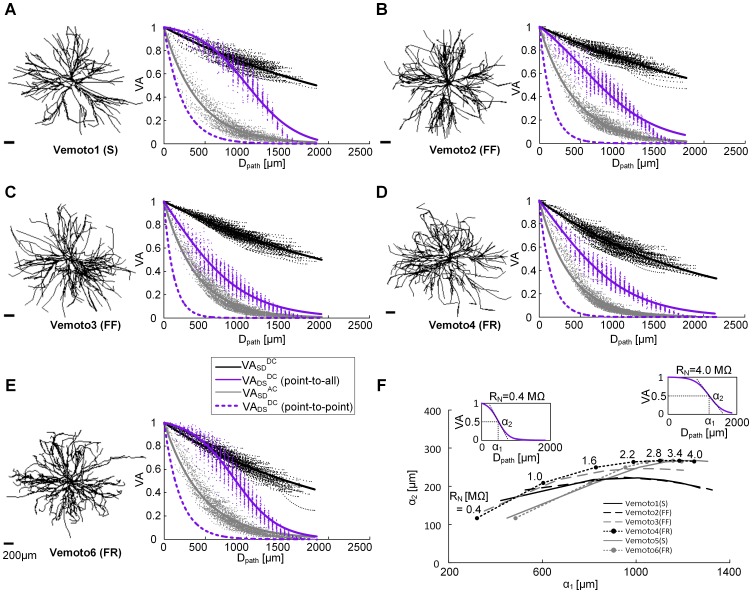
Characterization of voltage attenuation property of the dendrites.(A) – (E). Morphologies of the motoneurons in the left column and the three voltage attenuation (VA) factors measured at all distances (Dpath) from the soma (VASD
DC in black, VASD
AC in gray and VADS
DC in purple) in the right column. A single exponential function (exp(-Dpath/λ)) was used to fit the VASD
DC (λ = 2678.7, 3085.6, 2763.7, 1945.5 and 2156.4 for A–E) and VASD
AC (λ = 420.1, 437.1, 402.3, 373.1 and 464.7 for A–E), and a modified Boltzmann equation (1/[1−exp(−α1/α2)+exp((Dpath−α1)/α2)]) for VADS
DC (α1& α2 = 1020.8&307.7, 635.2&439.5, 327.9&469.6, 374.2&504.8 and 861.9&268.3 for A–E). Note that purple solid lines represents the VADS
DC between the soma and all points in the dendrites at the same distance (i.e. point-to-all) whereas purple dotted lines (exp(-Dpath/λ) where λ = 225, 143.6, 118.5, 144, 193.7 for A–E) for the VADS
DC between the soma and a single point along the path of all individual dendritic trees from the soma (i.e. point-to-point). (F). The VADS
DC was measured in six type identified anatomically reconstructed motoneurons while varying the input resistance (RN) from 0.4 to 4.0 MΩ. The α1 (the distance at which the VADS
DC dropped to 50%) parameter was more sensitive to changes in RN compared with α2 parameter (a measure of the slope of the curve at α1). The insets show examples of the VADS
DC curves at extreme RN values of 0.4 and 4.0 MΩ. Note that the distribution of points (α1, α2) at the same RN is not type specific (e.g. gray and black filled circles for FR-type motoneurons). S, FR and FF indicate slow twitch, fast twitch and fatigue resistant, and fast twitch and fast fatigable motoneuron type respectively.